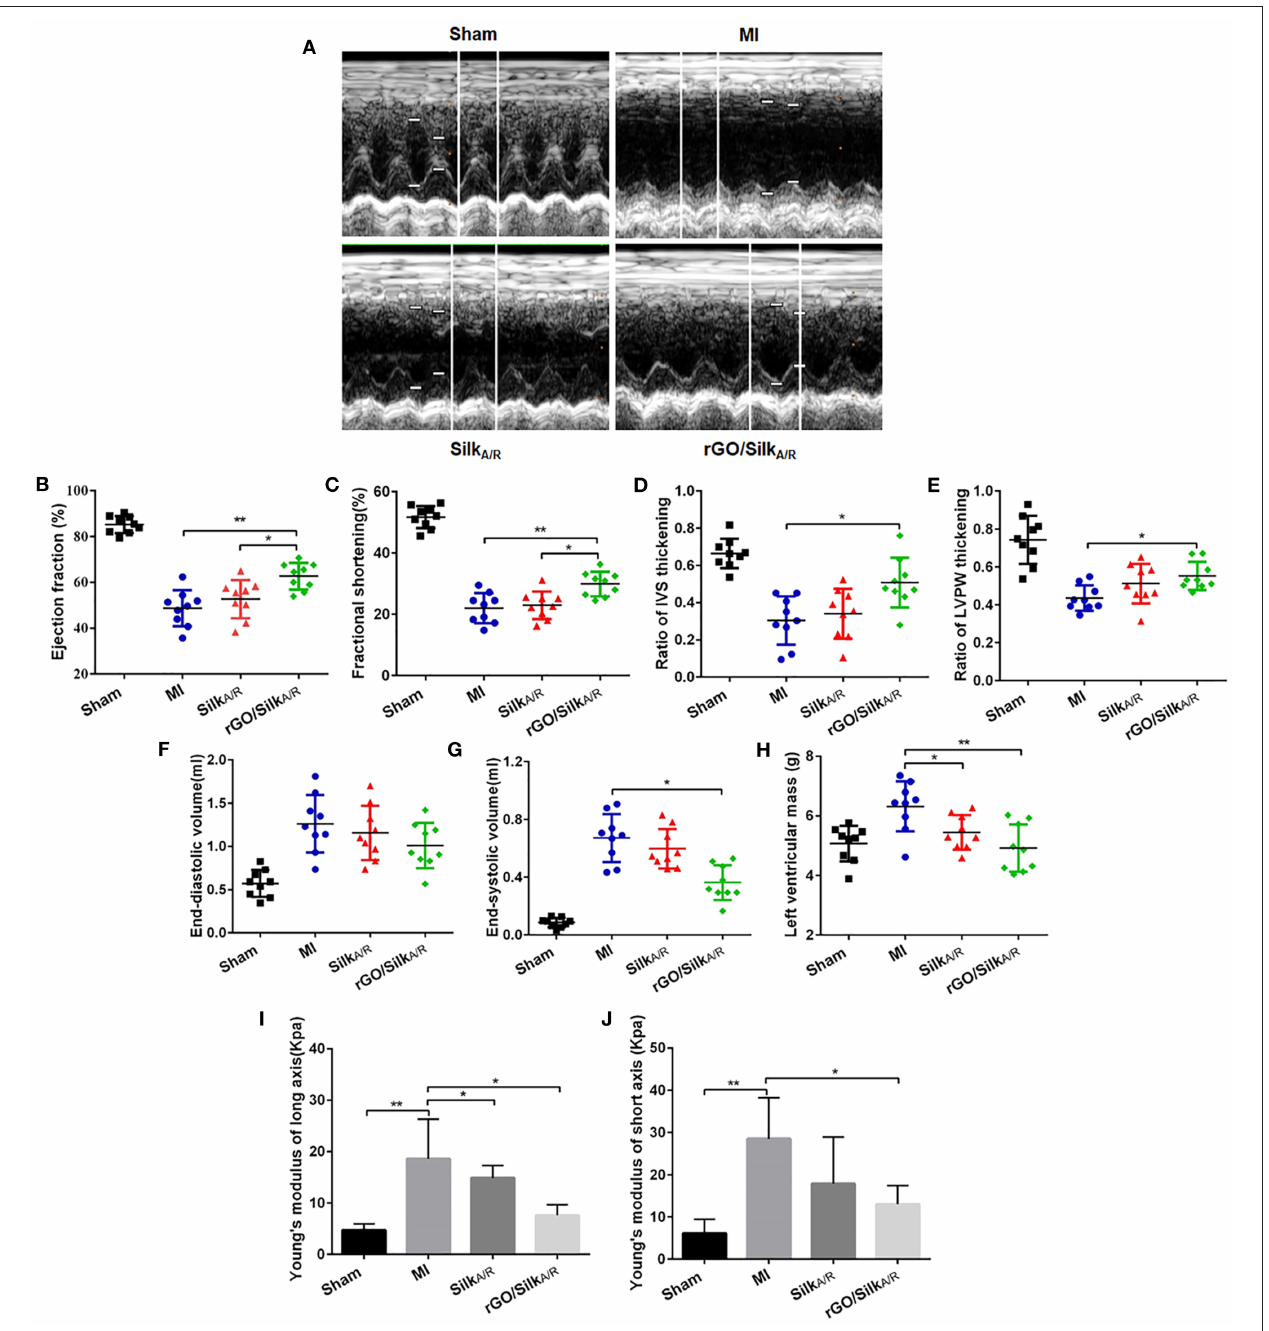
FIGURE 1 | Echocardiographic measurements and biomechanical tests of the effects of rGO/silk cardiac patches on the myocardial functional recovery of infarcted hearts of rats. (A) Echocardiography was performed at 4 weeks’ post-implantation of patches. Quantification of parameters reflecting blood pumping function, including ejection fraction (B) , fractional shortening (C) , ratio of interventricular septum (IVS) thickening (D) and ratio of left ventricular posterior wall (LVPW) thickening (E) at 4 weeks after MI. Quantification of parameters reflecting ventricular remodeling, including left ventricular end-diastolic volume (F) , end-systolic volume (G) and left ventricular mass (H) . Young’s modulus both in long axis (I) and short axis (J) were gauged by an BOSE Electro Force mechanical tester. Data are mean ± SEM from three independent experiments. * P < 0.05, ** P < 0.01.